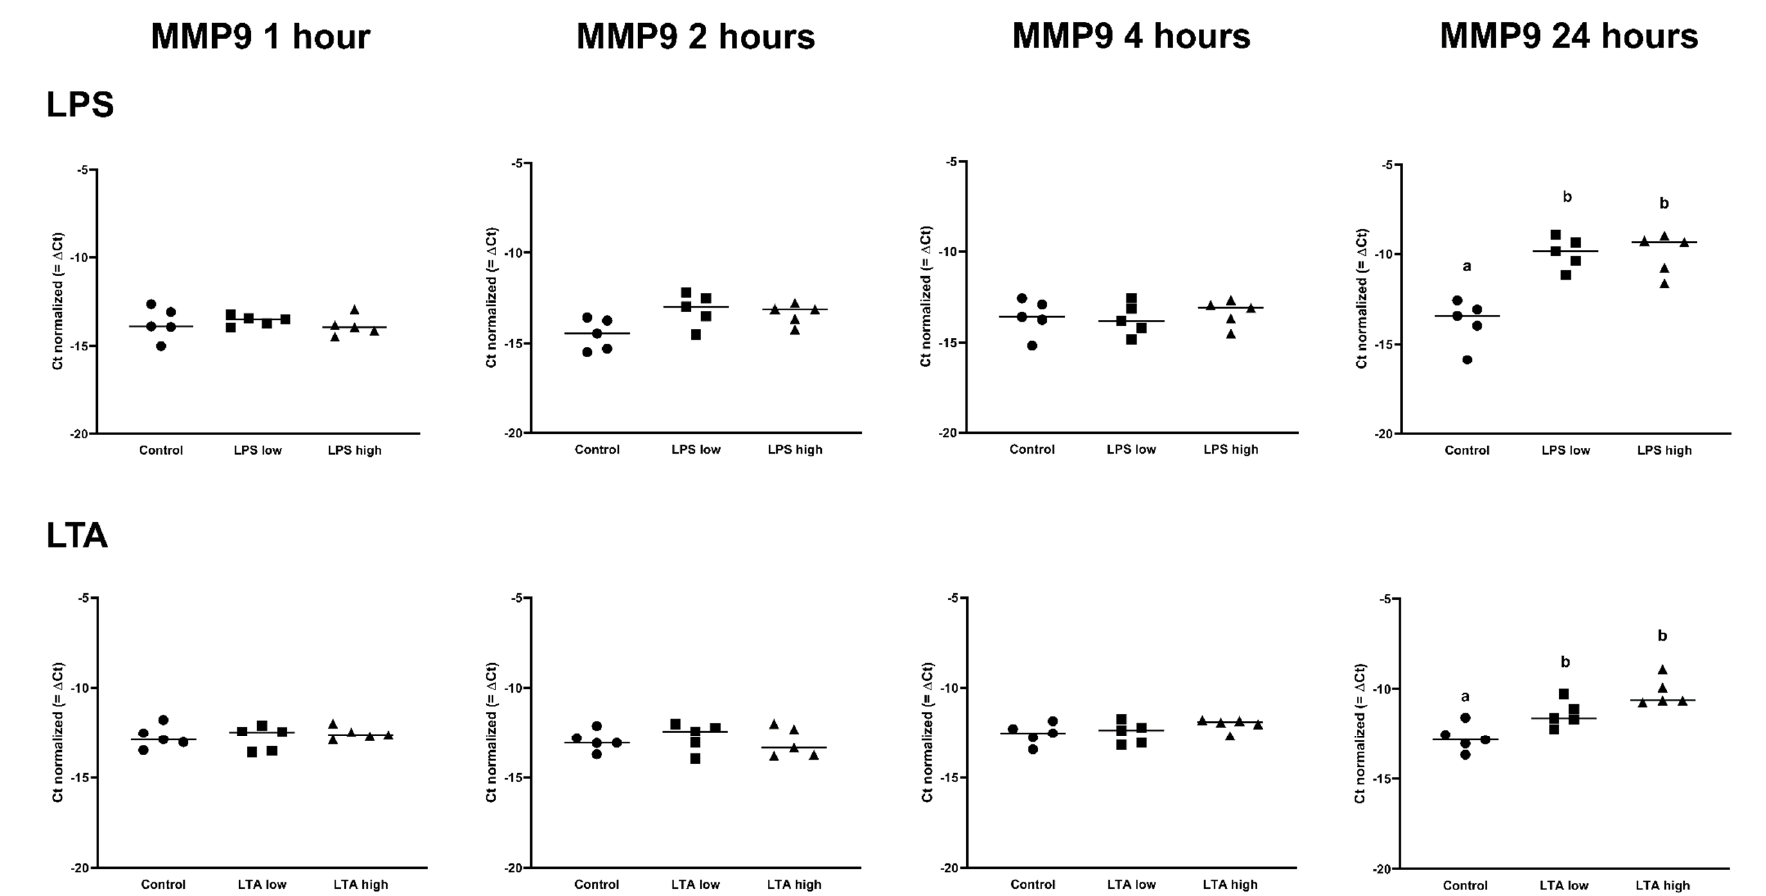
Figure 5. Delta Ct values of MMP9 of RECs treated for 1, 2, 4, and 24 h with 0 µg/mL (Control), 1 µg/mL LPS (LPS low), 10 µg/mL (LPS high), 1 µg/mL LTA (LTA low), and 10 µg/mL LTA (LTA high). n = 5 independent experiments. a,b Superscripts indicate significant differences within 1, 2, 4, and 24 h: p < 0.05.